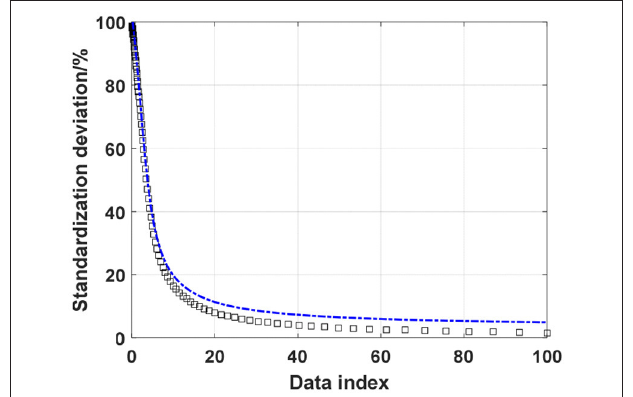
FIGURE 2 | The distribution of the standardized deviation curve of the cognitive impact model.